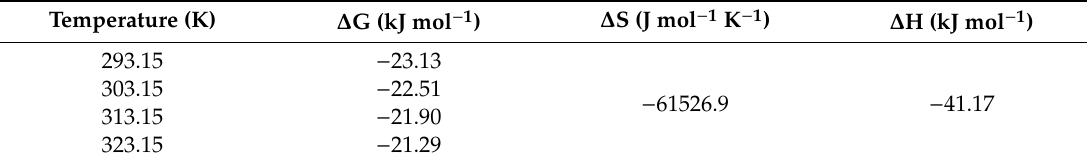
Figure 10. Van’t Ho ff plot for the investigated adsorbents. Figure 10. Van’t Hoff plot for the investigated adsorbents. Table 5. Thermodynamic parameters for the absorption of Pt(CN) 42 − Table 5. Thermodynamic parameters for the absorption of Pt(CN) 42 − .